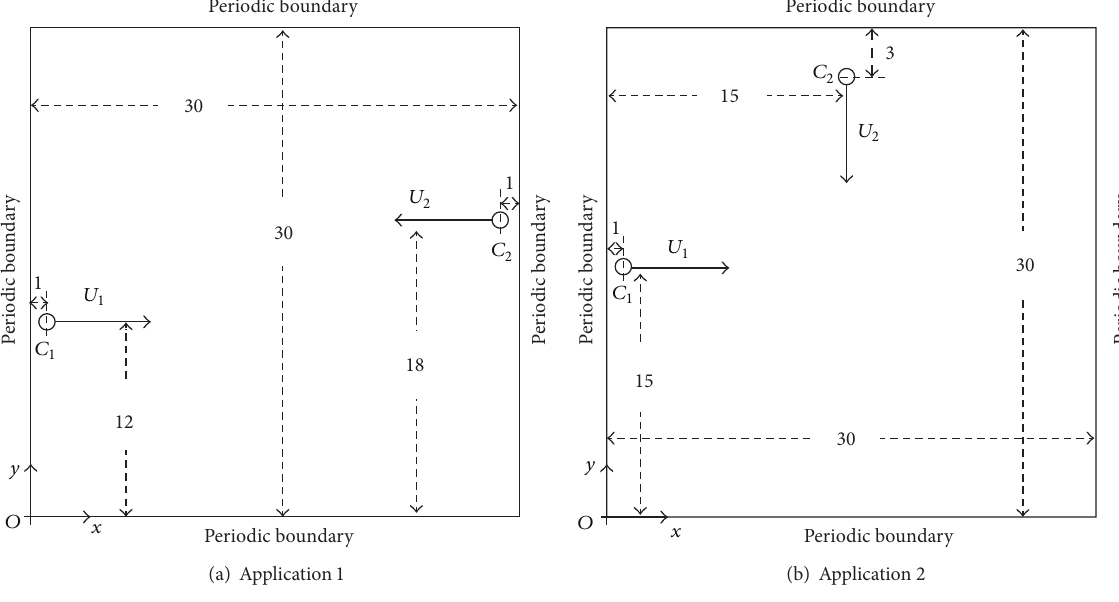
Figure 19: Computational configurations of the applications discussed in the